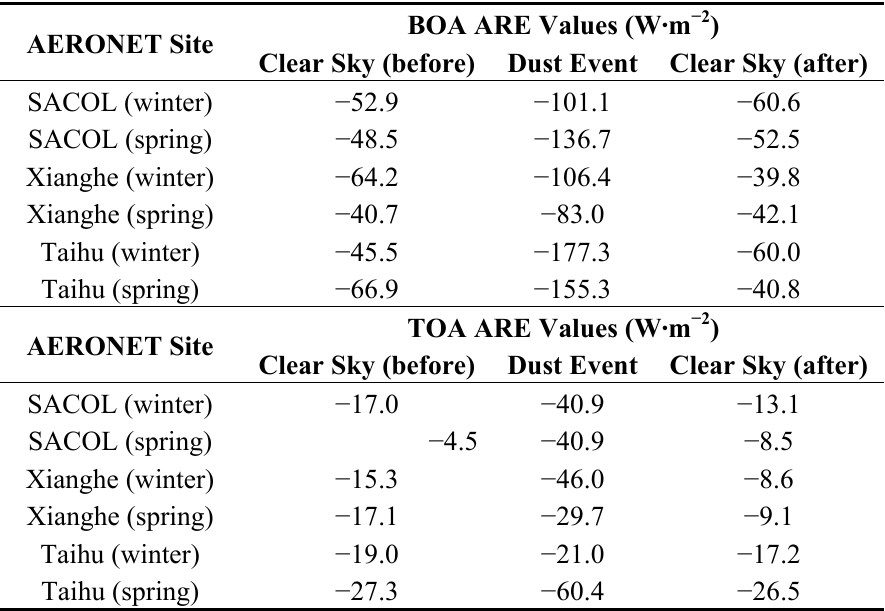
Table 3. Summary of the AERONET calculated BOA (2 km) and TOA (120 km) aerosol radiative effect (ARE)